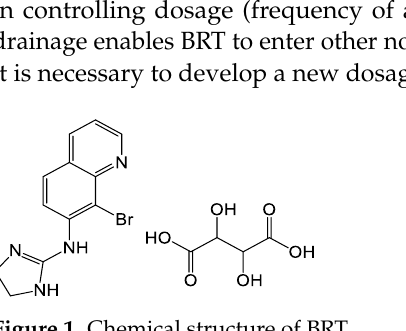
Figure 1. Chemical structure of BRT.